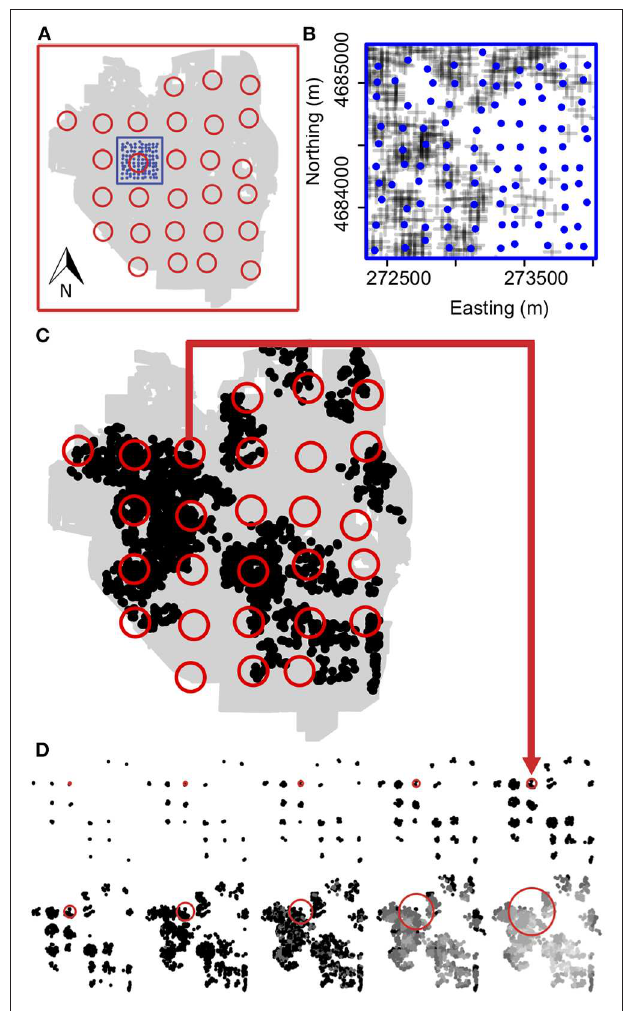
FIGURE 2 | Sampling scheme and scale-dependent landscape structure. (A) Sampling scheme of gardens in the area of Ann Arbor, MI (grey background). Sampling of arthropods was conducted regularly across the entire landscape in two plots (red box: landscape and blue box: local) and three time points (June, July, and August 2013). A total of 28 samples were collected at the landscape (open red circles), and 100 at the local plots (blue circles) per month. (B) Close-up of sampling locations (blue dots) and easement gardens (plus signs) in local plot. Landscape-plot samples are drawn in (C) at a radius of 400m on top of actual distribution of urban gardens (closed black circles). Patch size was equal to number of gardens falling within the radius of a single sampling circle, visualized in (D) by plotting only the gardens (black/gray points) falling within radii of 100, 150, 200, 300, 400m (top row), and 500, 750, 1,000, 1,500, 2,000m (bottom row) for the 28 landscape-level sampling points only. One patch is highlighted for each radius (open red circles) to show scale, with a red arrow connecting this point to its location among all landscape-level sample points plotted at the same 400m radius in (C) . At a radius of 1,000m and beyond, neighboring landscape-level samples begin to overlap; degree of overlap is indicated by the darkness of garden points with lightest points having the greatest overlap. The same patch size analysis was done for local plot samples, but not visualized